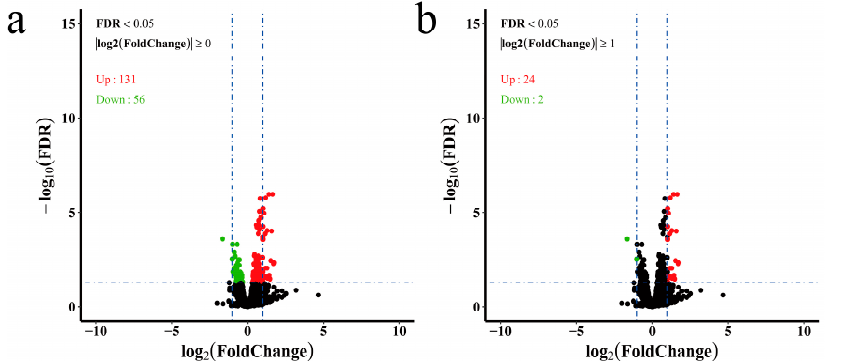
Figure 1. Volcano plot of differentially expressed genes. ( a ) DEGs with adjusted p value < 0.05 were chosen for volcano plot; ( b ) DEGs with adjusted p value < 0.05 and |log2FoldChange| ≥ 1 were chosen for volcano plot. The green dots represent downregulated genes, the red dots represent upregulated genes, and the black dots represent genes that were not significantly differentially expressed.